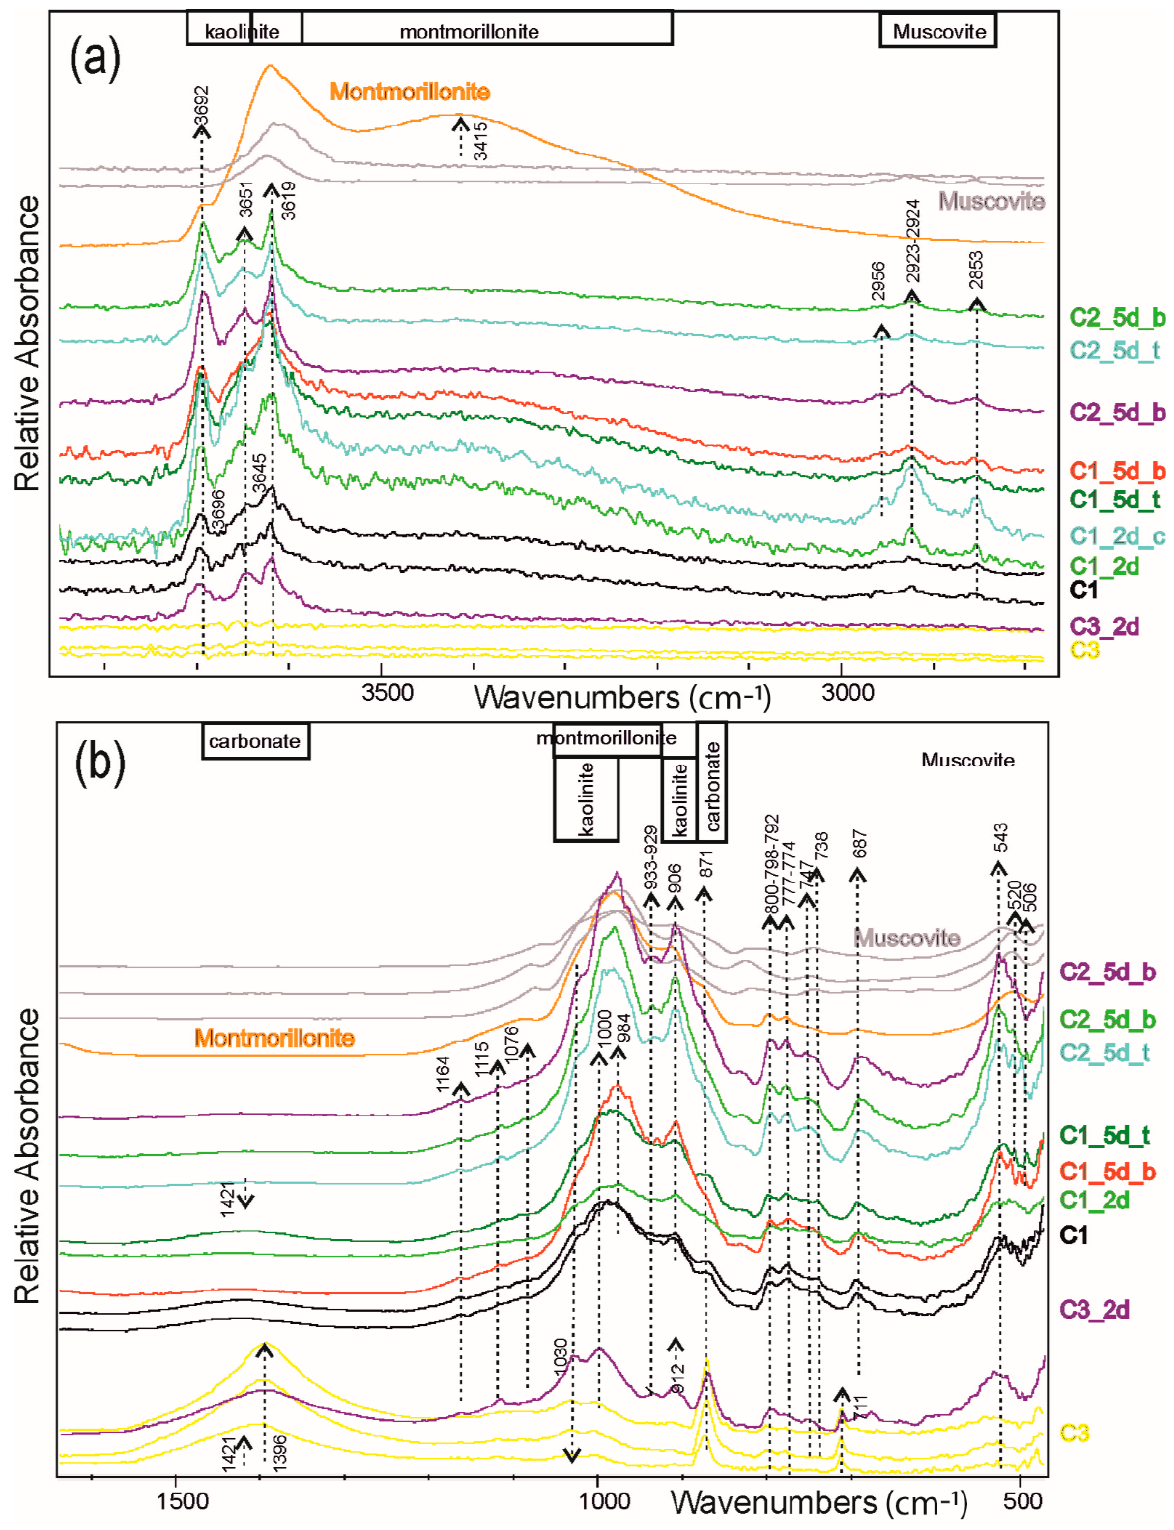
Figure 4. FT-IR spectra ( a ) in the 3850 – 2780 cm − 1 and ( b ) in the 1780 – 470 cm − 1 range of C1, C2 and C3 granular samples pressed under the ATR module with indication of main signals (vertical dotted lines with arrows). Aliquots after experiments are those reporting in sample names “2d” and “5d” for 2 days and 5 days of hydrothermal interaction, respectively. Montmorillonite and muscovite are from the USGS database. Upper boxes indicate the absorption bands for discriminant minerals.